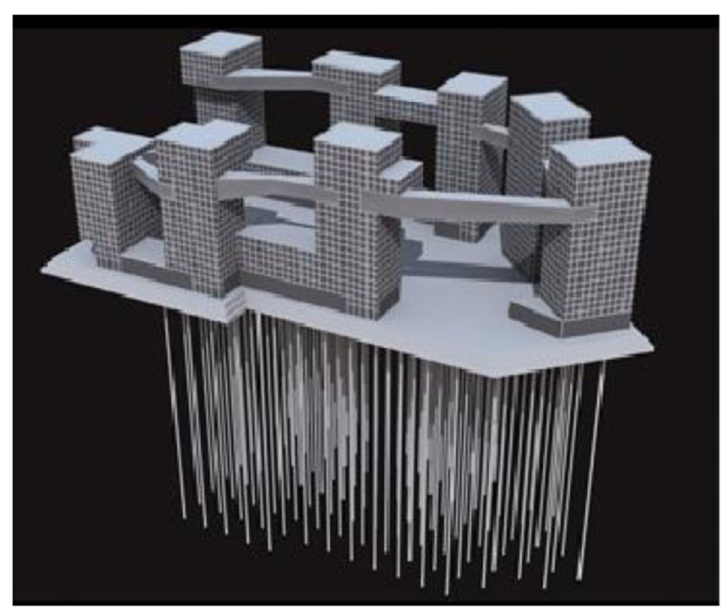
Fig. 17 Buried pipes of GSHP system in Beijing contemporary world city